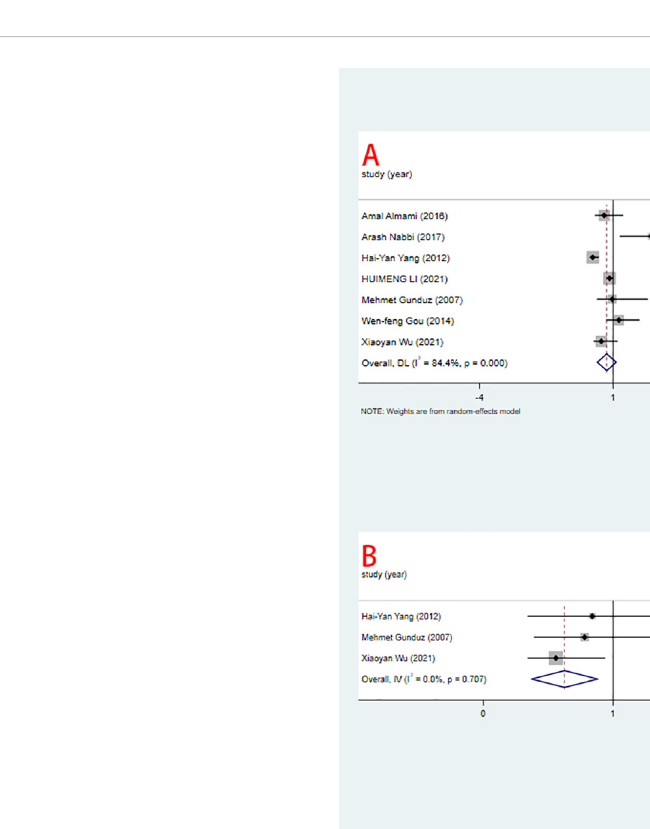
FIGURE 2 Relationship between ING3 expression and OS (A) , DFS (B) (high vs low).